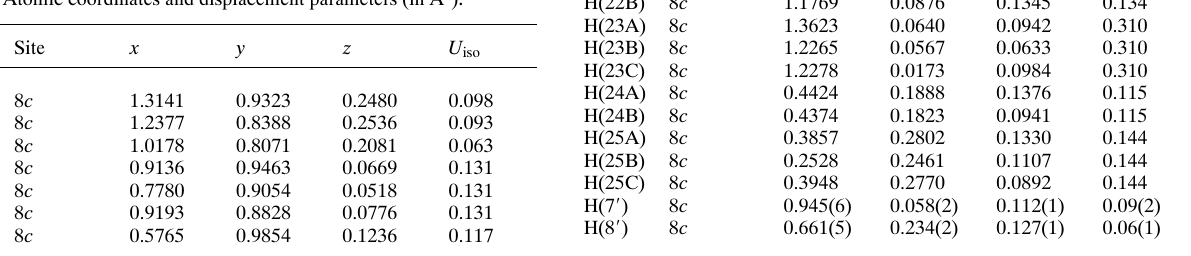
Table 2. Atomic coordinates and displacement parameters (in Å 2 ) .